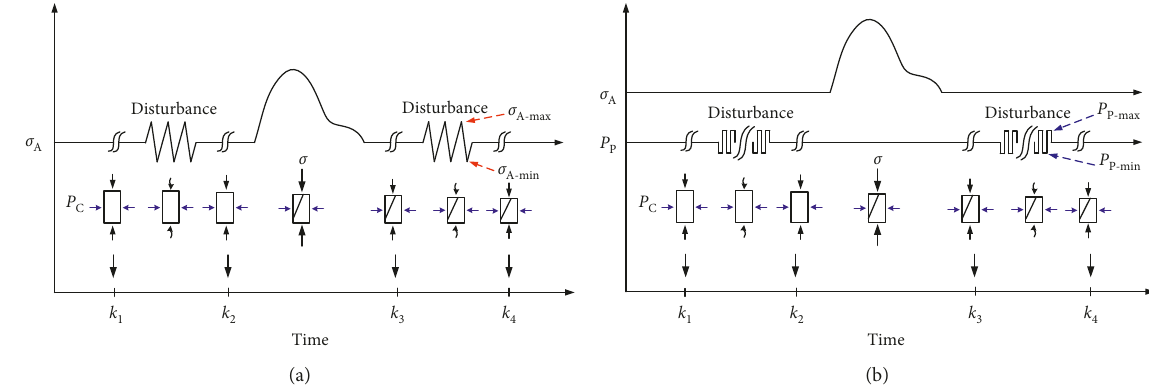
Figure 3: Experimental procedure for the Kushiro Cretaceous sandstone. (a) Axial stress disturbances; (b) pore pressure